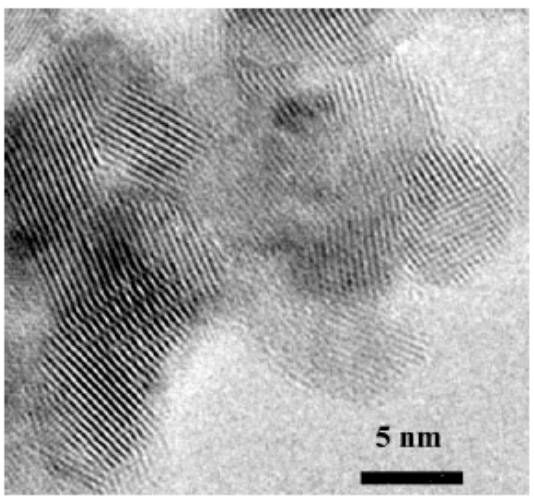
Figure 1. TEM image of TiO 2 : 2 mol% Nb nanopowder calcined at 500 °C for 4 h.